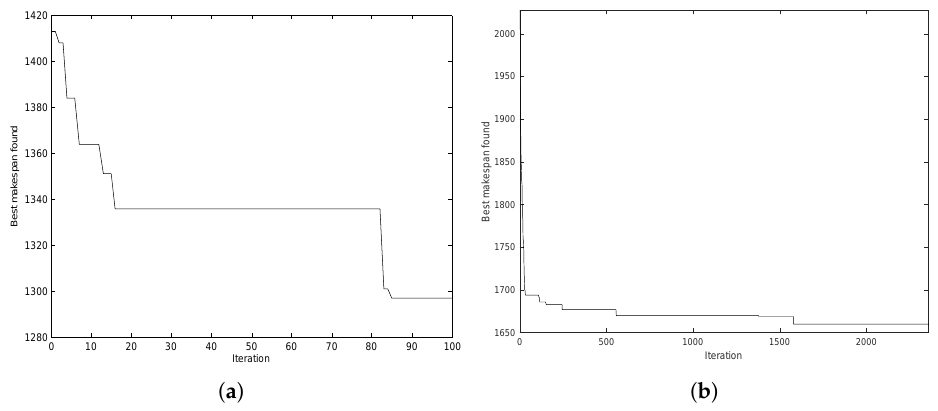
Figure 8. So-far-Best solution versus iteration in the benchmark instances ta001 ( a ) and ta012 ( b ). Comparison with Other Metaheuristics RDIS is compared with a variety of metaheuristic in terms of solution quality and computation time. In particular, as presented in Table 1, RDIS is compared with the Re- blocking Adjustable Memetic Procedure (RAMP) of [39] NEGA VNS of [43], Particle swarm optimization algorithm, PSO VNS ,of [44], Simulated Annealing algorithm, SAOP, of [45]